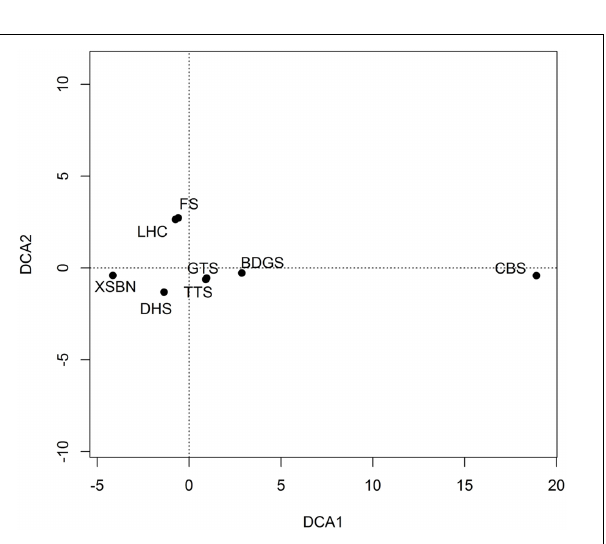
of the total variance in β j , β s , and β sim , respectively; and spatial factors explained 47.92, 48.39, and 41.38% of the total variance in β β β j , s , and sim ,